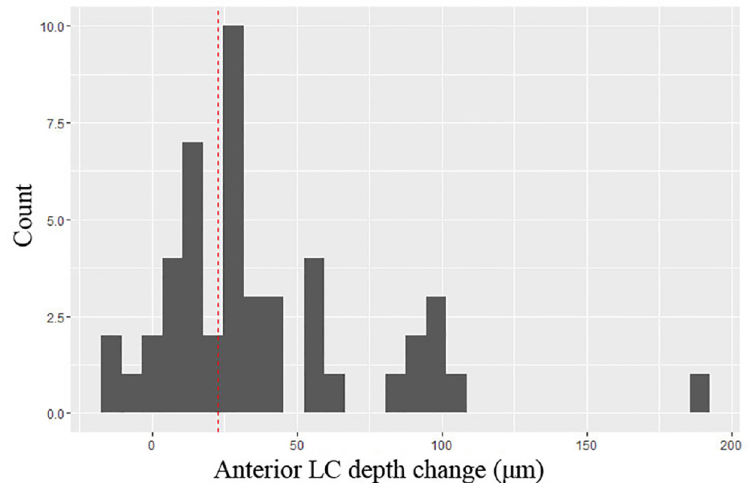
maneuver. Twenty-nine eyes (60.4%) showed significant anterior displacement of the LC during the standardized Valsalva maneuver. Only three eyes (6.3%) showed posterior displacement (10.0 – 17.0 μ m). The vertical red dotted line depicts the 1.96-times intersession SD of the OCT measurements (22.5 μ m).